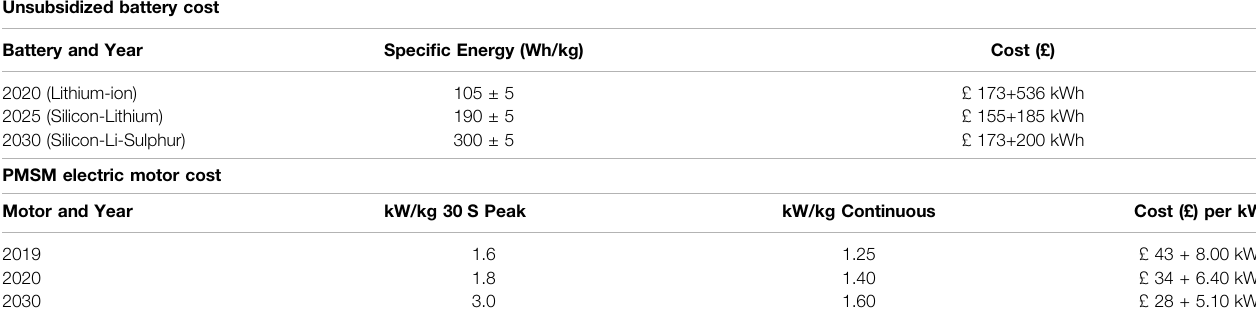
TABLE 9 | Unsubsidized battery and PMSM electric motor cost for years 2019 –